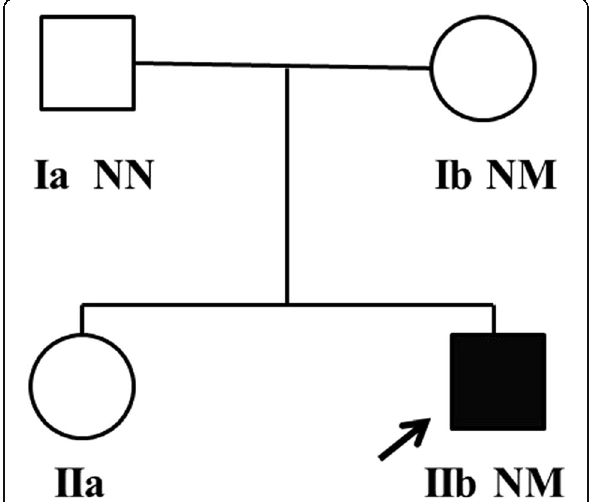
Fig. 1 Pedigree of family in this study. Squares represent male family members, while circles represent female family members. Black symbol represents individual with GSD IXa, blank symbols represent normal individuals. Arrow indicates proband in the family (IIb). Variant carrier status present as N: Normal allele and M: Mutation. The sequence data displayed heterozygous mutation in PHKA2 (c.2972C > G, p.G991A) in proband and his mother